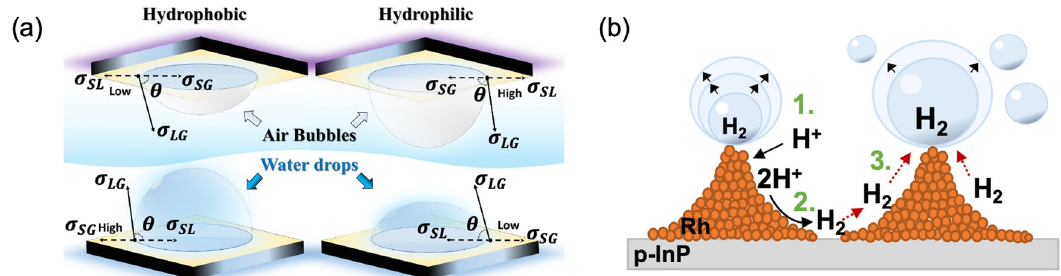
Fig. 4 Electrode surface modi fi cations for increased gas bubble detachment in microgravity. a Scheme illustrating the difference between hydrophobic and hydrophilic surfaces when in contact with (air) gas bubbles (top) and water droplets (bottom). b Diagram of the improved mechanism for hydrogen bubble nucleation and reduced bubble coalescence on nanostructured photoelectrode surfaces in a microgravity environment according to ref. 35